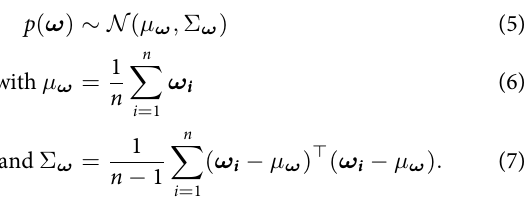
Frontiers in Robotics and AI |